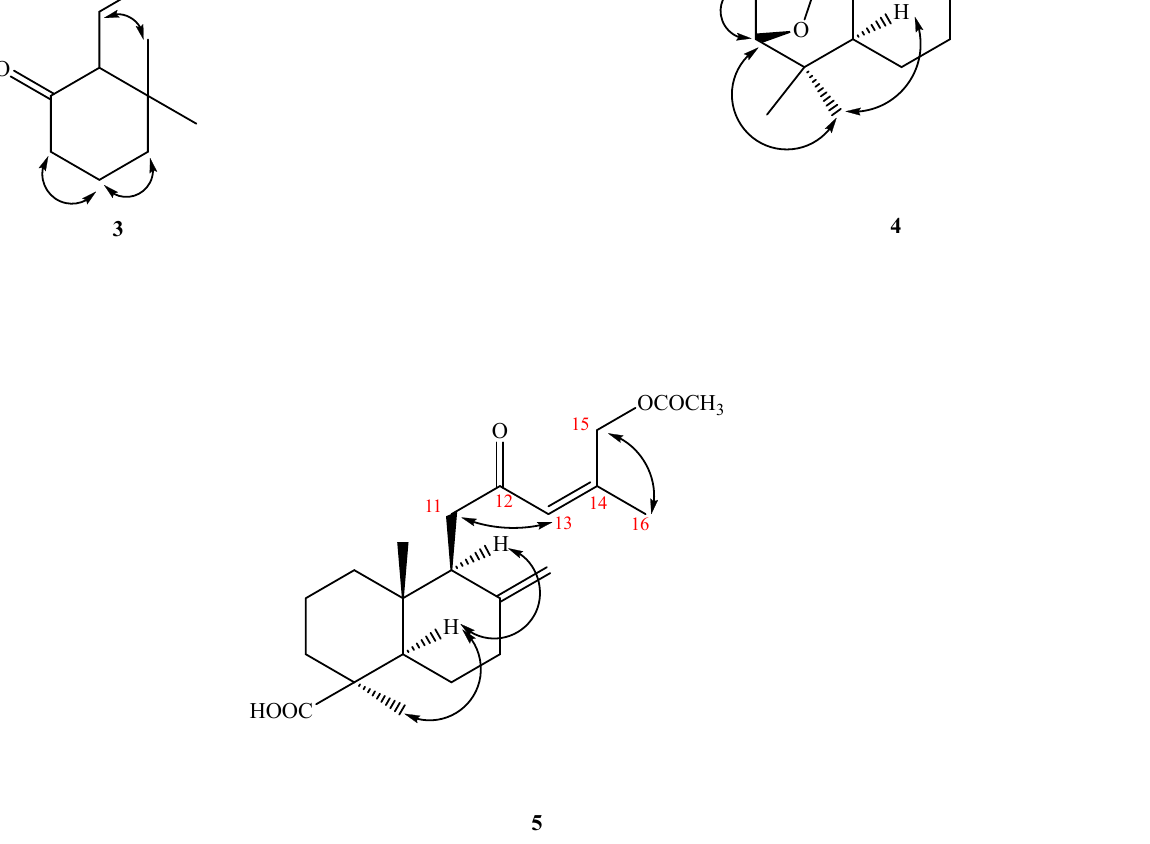
Figure 4. Key NOESY correlations ( ↔ ) of Compounds 1 ‒ 5 .